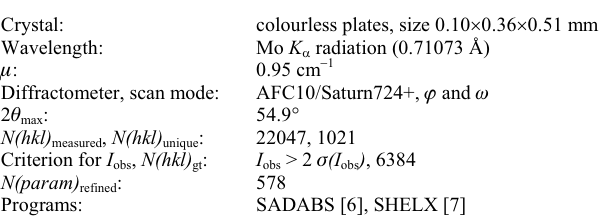
Table 1. Data collection and handling.